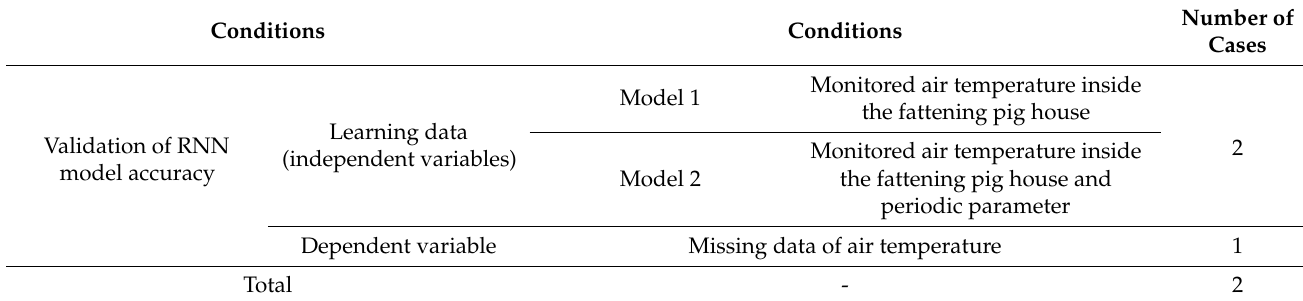
Table 2. Experimental conditions of learning data for developing the RNN